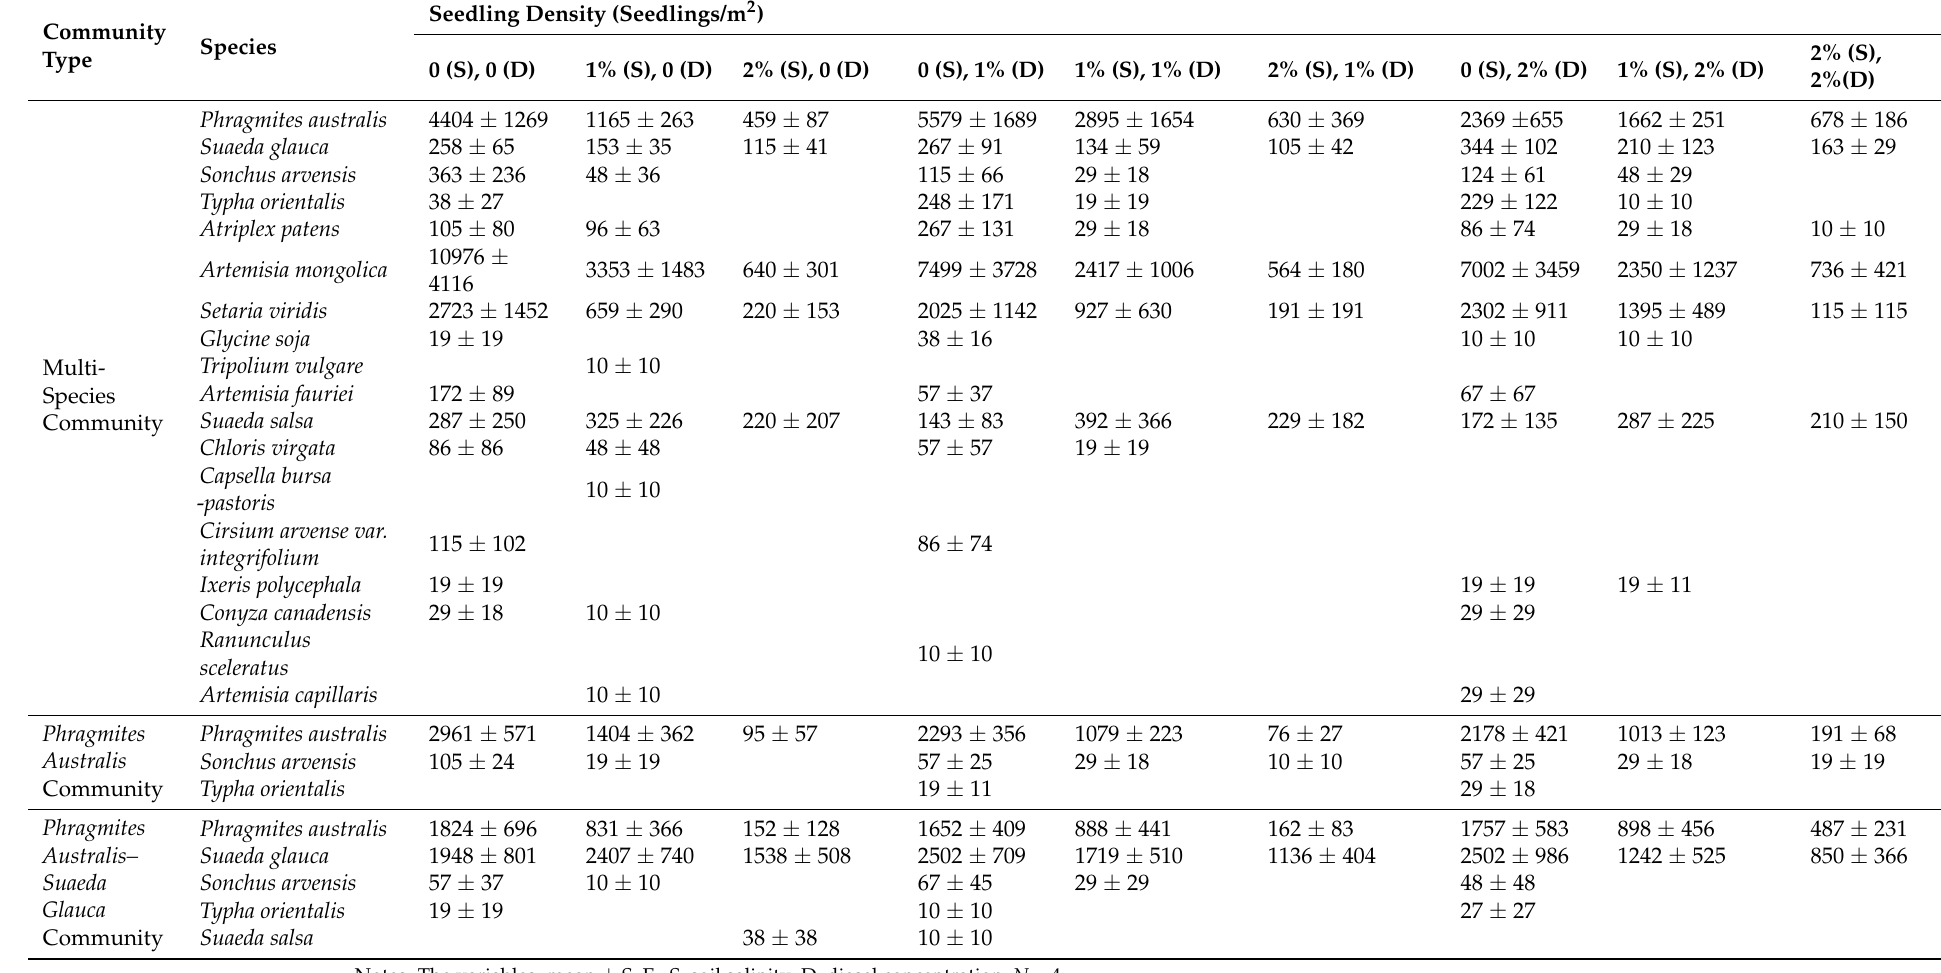
Table 3. Seedling number in the seed banks of the three dominant vegetation communities in the